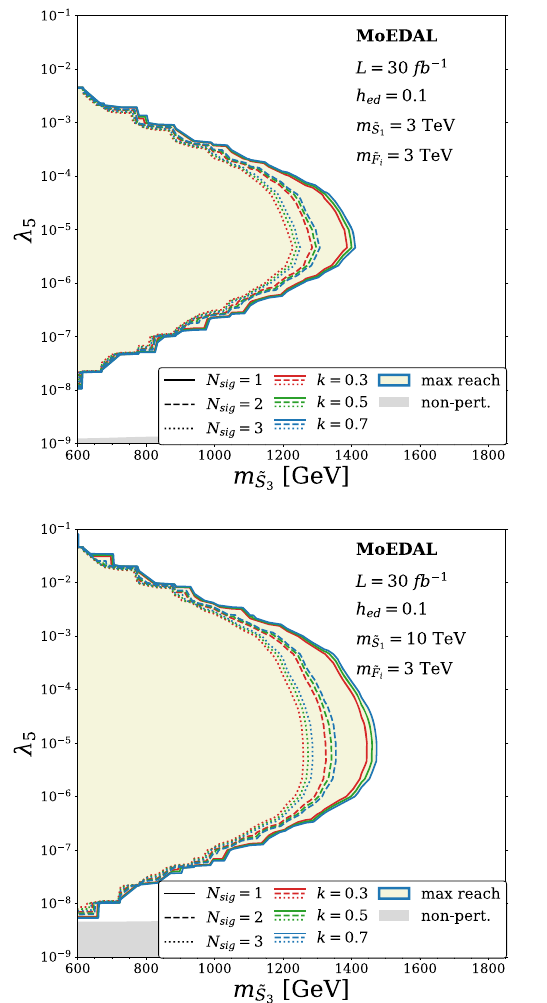
not observe any signal event. The left and right panels correspond to , 3 L = 30 and 300 fb − 1 , respectively. We take m ˜ = 3 (10) TeV in the top (bottom) panels. The h for all plots and m ˜ S 1 and h ¯ are fitted to the neutrino data. In the grey region one of these F couplings tend to be non-perturbative; max ij